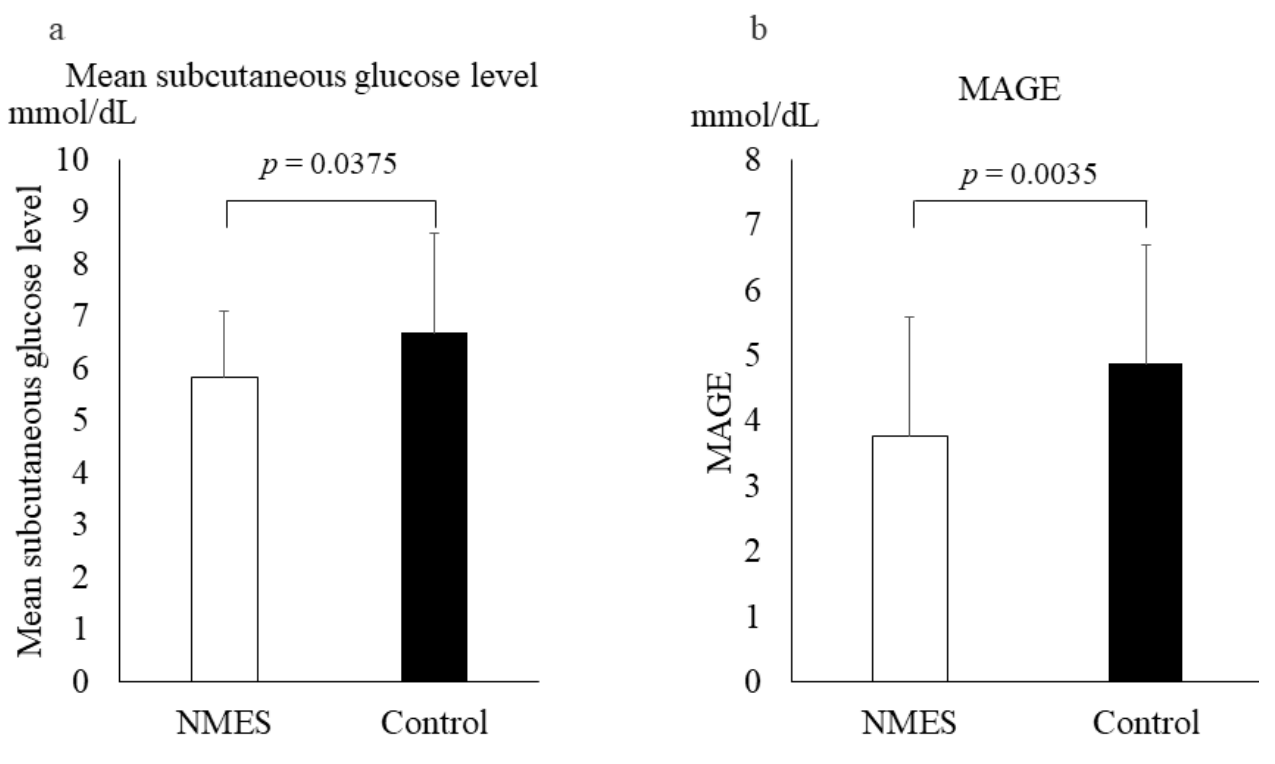
Figure 2. ( a ) Mean subcutaneous glucose level and ( b ) mean amplitude of glycemic excursion (MAGE) for 24 h after completion of hemodialysis with a single bout neuromuscular electrical stimulation (NMES) session after supplementary nutritional food intake in stage 1; NMES: white bars, control: black bars. Values represent the mean ± standard deviation of the 11 participants. Mean blood glucose level after hemodialysis for >24 h. Paired t -test of Δ values when comparing differences between periods. Effect of the 12 week NMES on Glycemic Control.